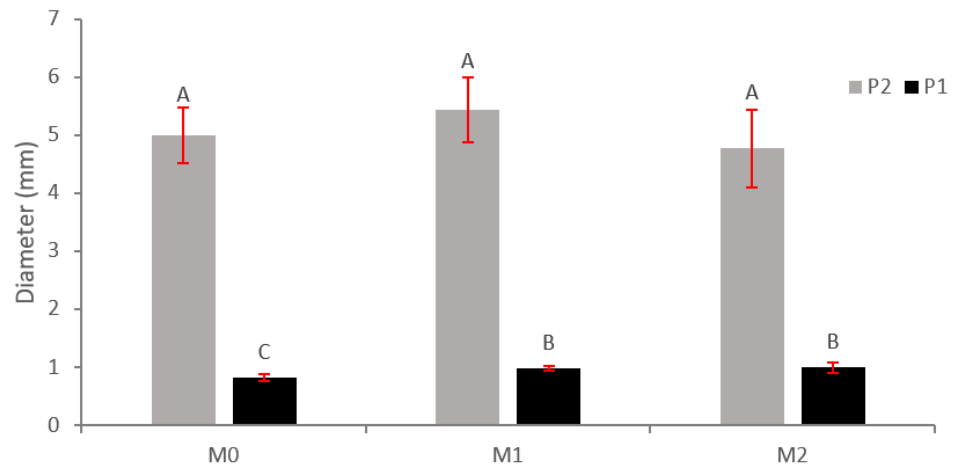
Figure 3. Cumulative increase in shoot diameter (mm) in N. alessandrii plants as a function of application of MFI (M0, M1, and M2) and plant type (P1 and P2). Different letters represent significant differences at p < 0.05 .